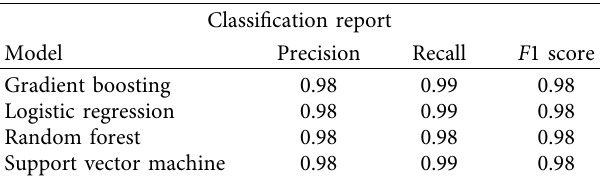
Table 2: Precision, recall, and F 1 score weighted macro average